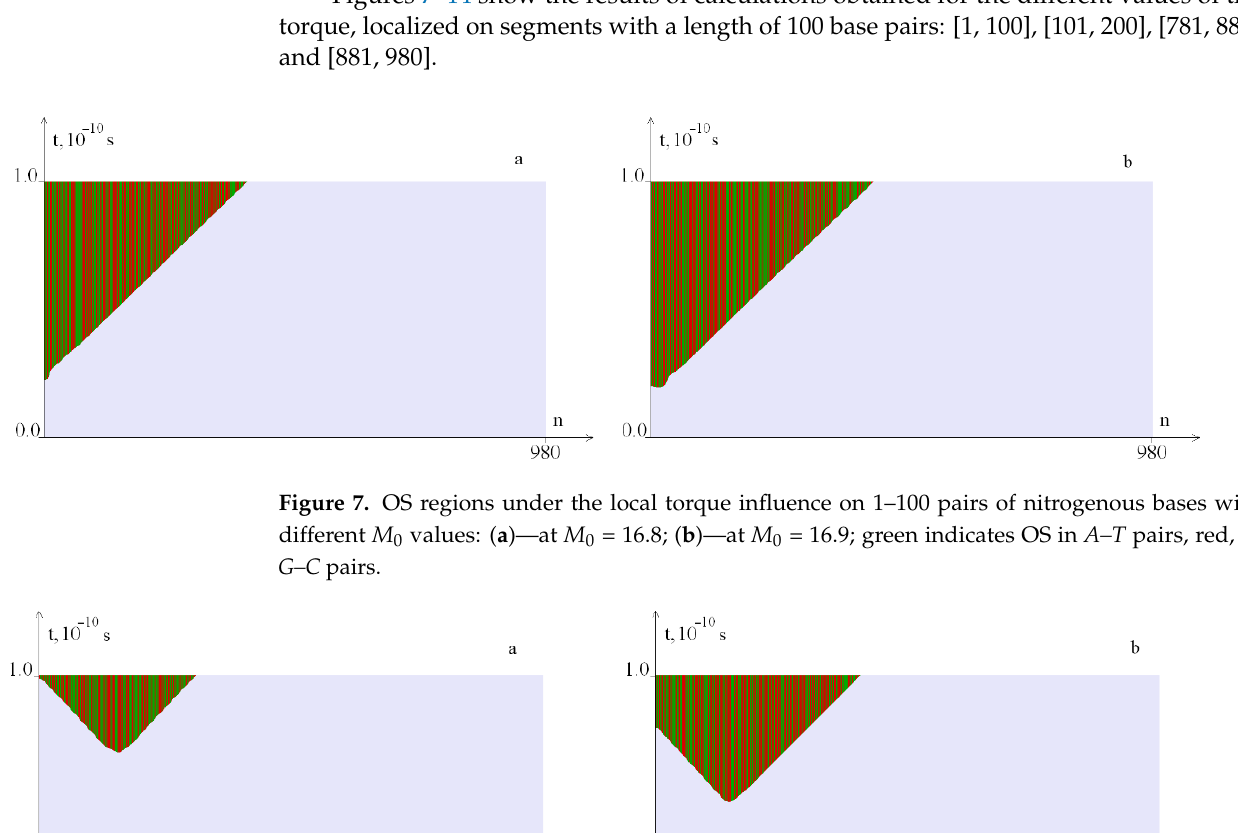
Figure 9. Graphs of the probability (in percent) of OS occurrence under the action of a torsion mo- ment localized on the segment [1, 100] (thin line) and on the segment [101, 200] (thick line). Figure 10 shows graphs of the angular deviations of the first DNA molecule of the strand under the localized torque action on the segment [781, 880] at M 0 = 15.045, at which OS does not yet occur.